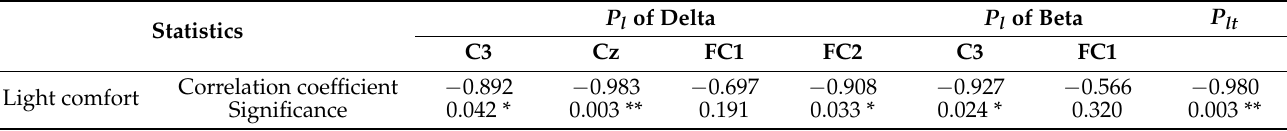
channel were negatively correlated with the subjective evaluation results. Table 9. Correlation analysis